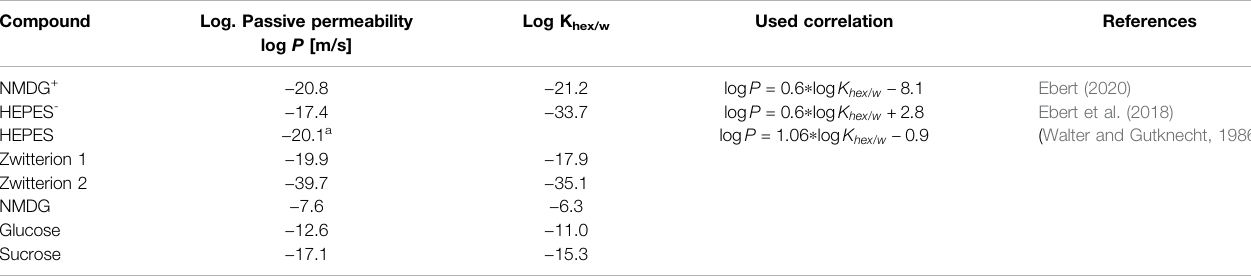
TABLE 4 | Estimated values for passive HEPES 0 , HEPES - , glucose, sucrose, NMDG 0 , and NMDG + membrane permeabilities, the corresponding hexadecane/water partition coef fi cients K hex/w (see Sections 4.3 and 4.4) and the pertinent correlations to calculate logP. Compound Used correlation